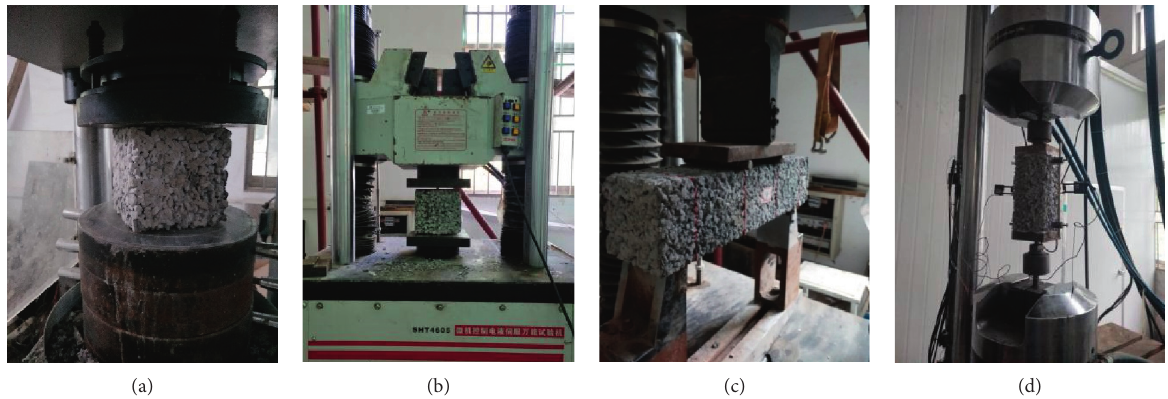
Figure 2: Testing methods under different working conditions.